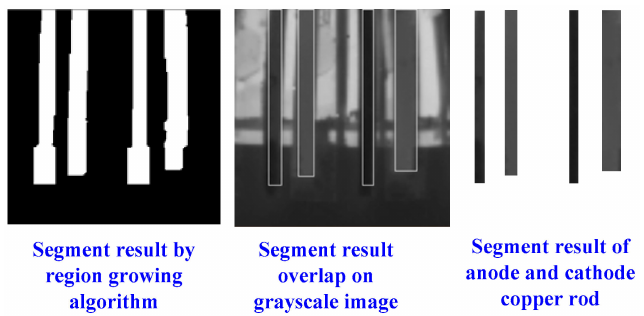
Figure 12. Result of the copper rod